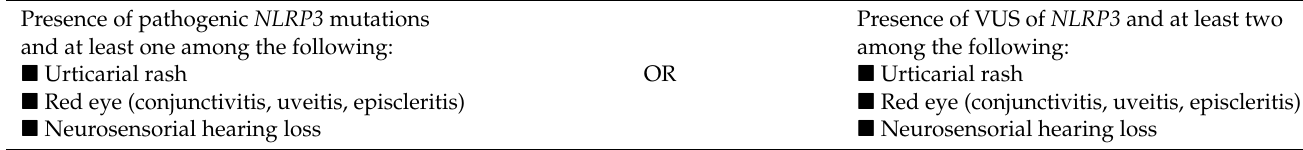
Table 3. New Eurofever/PRINTO Classification Criteria for CAPS. Presence of pathogenic NLRP3 mutations and at least one among the following: (cid:4) Urticarial rash (cid:4) Red eye (conjunctivitis, uveitis, episcleritis) (cid:4) Neurosensorial hearing